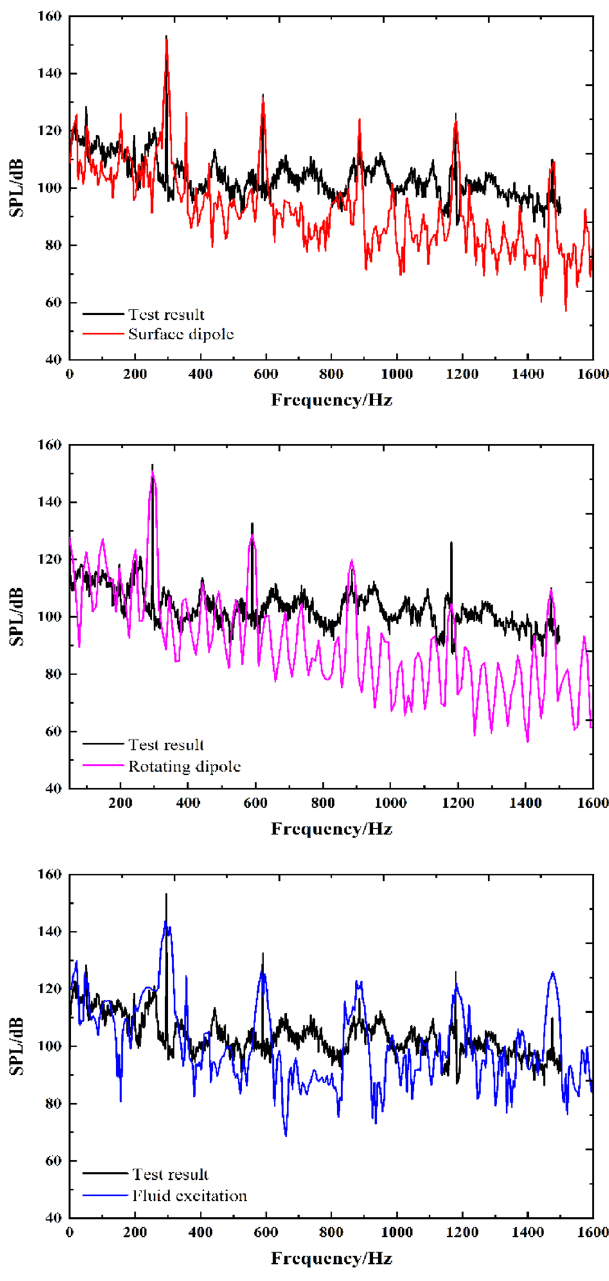
Figure 11. Broadband spectrum of the simulation and experimental